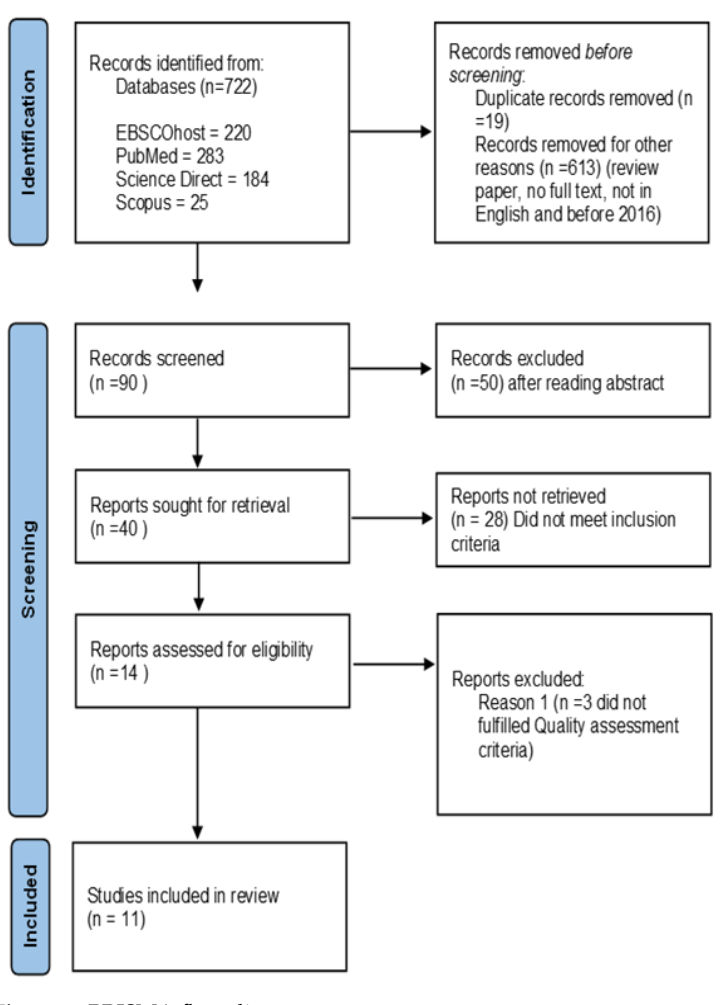
Figure 1. PRISMA flow diagram. Table 1. Results of the Critical Appraisals for Inclusion or Exclusion of Randomised Controlled Tri- als.